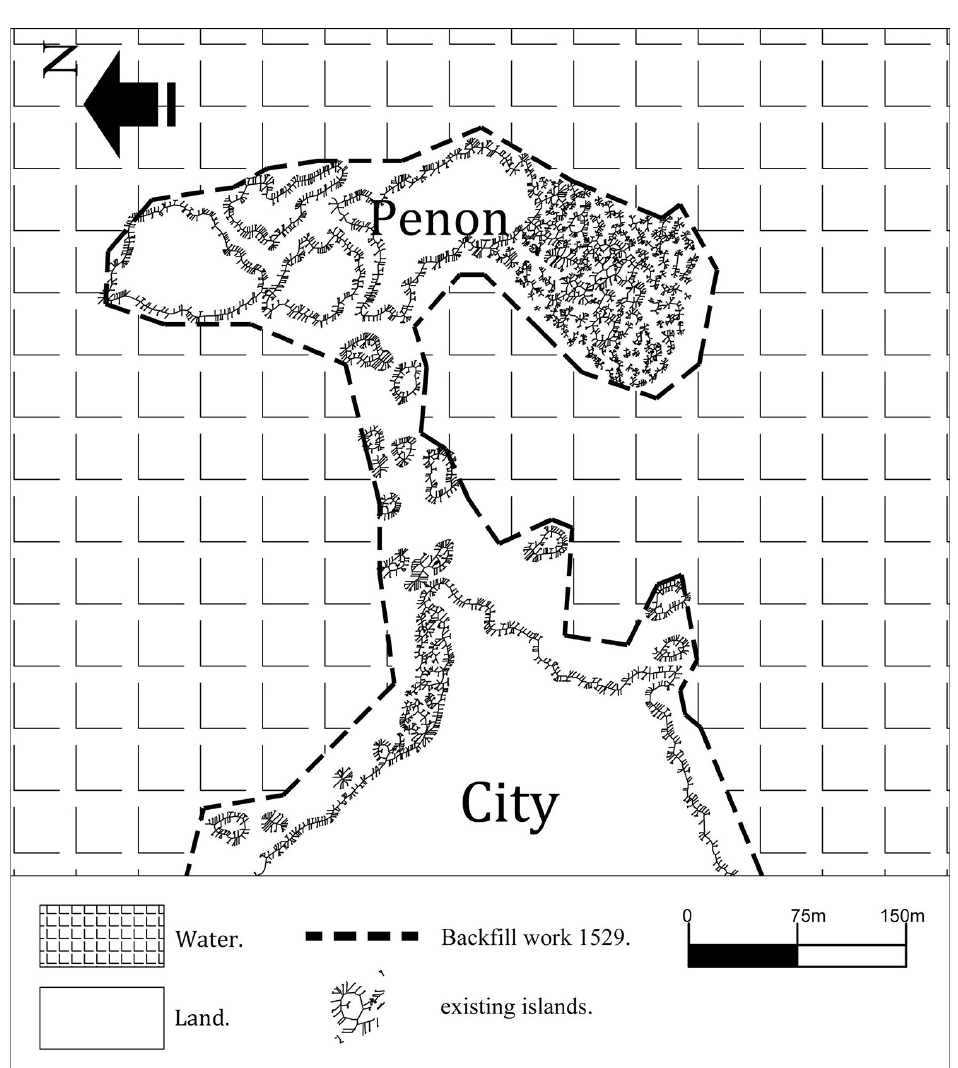
Figure 3. Map of the Penon and the city before 1529, providing an overview of the connecting backfill works that were carried out. Source: Produced by the authors, based on Meunier